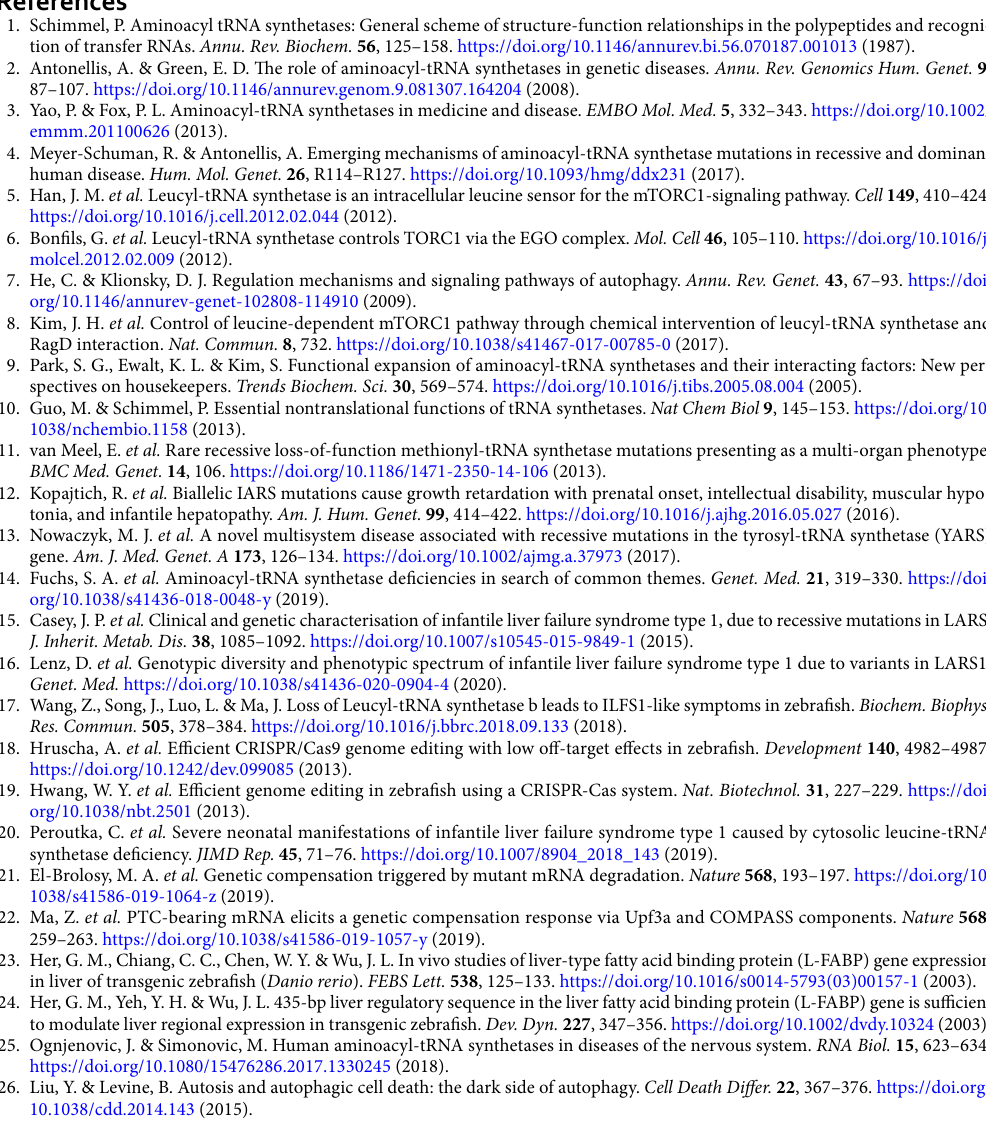
Figure 5. Inhibition of autophagy prevents abnormal development and improves survival in larsb- knockout larvae. (A) Morphology of larsb + / + and larsb −/− embryos injected with either control MO or atg5-MO (72 h post fertilization (hpf)). Scale bars: 500 µm. (B) Western blot analysis of Lc3b protein expression at 72 hpf for wild-type embryos injected with either control MO or atg5-MO. β-actin levels served as the loading control. (C) Morphological abnormality at 72 hpf in the livers of larsb −/− larvae under Tg[ fabp10 :mcherry] background injected with either control MO or atg5-MO. Scale bars: 200 μm. (D) Quantification of liver size in larsb −/− larvae under Tg[ fabp10 :mcherry] background (72 hpf). Liver sizes were evaluated using ImageJ software version 1.52a (https:// imagej. nih. gov/ ij/). n = 4 fish/group. Error bars indicate SEM. Student’s t-test; ***P < 0.001. (E) Western blot analysis of Lc3b protein expression at 72 hpf for wild-type embryos treated with DMSO or bafilomycin A1. β-actin levels served as the loading control. (F) Morphological abnormality at 72 hpf in the livers of larsb −/− larvae under Tg[ fabp10 :mcherry] background treated with DMSO or bafilomycin A1. Scale bars: 200 μm. (G) Quantification of liver size in larsb −/− larvae under Tg[ fabp10 :mcherry] background (72 hpf). Liver sizes were evaluated using ImageJ software version 1.52a (https:// imagej. nih. gov/ ij/). n = 10 fish/ group. Error bars indicate SEM. Student’s t-test; *P < 0.05. (H) Kaplan–Meier survival curve of larsb + / + (n = 23) and larsb −/− (n = 15) larvae treated with DMSO and larsb + / + (n = 11) and larsb −/− larvae (n = 21) treated with bafilomycin A1. Statistics were calculated and the figure was produced in GraphPad software version 8 (https:// www. graph pad. com/ scien tific- softw are/ prism/). Larsb: leucyl-tRNA synthetase b, MO: morpholino, n.s.: non- significant, DMSO: dimethyl sulfoxide, Dpf: days post